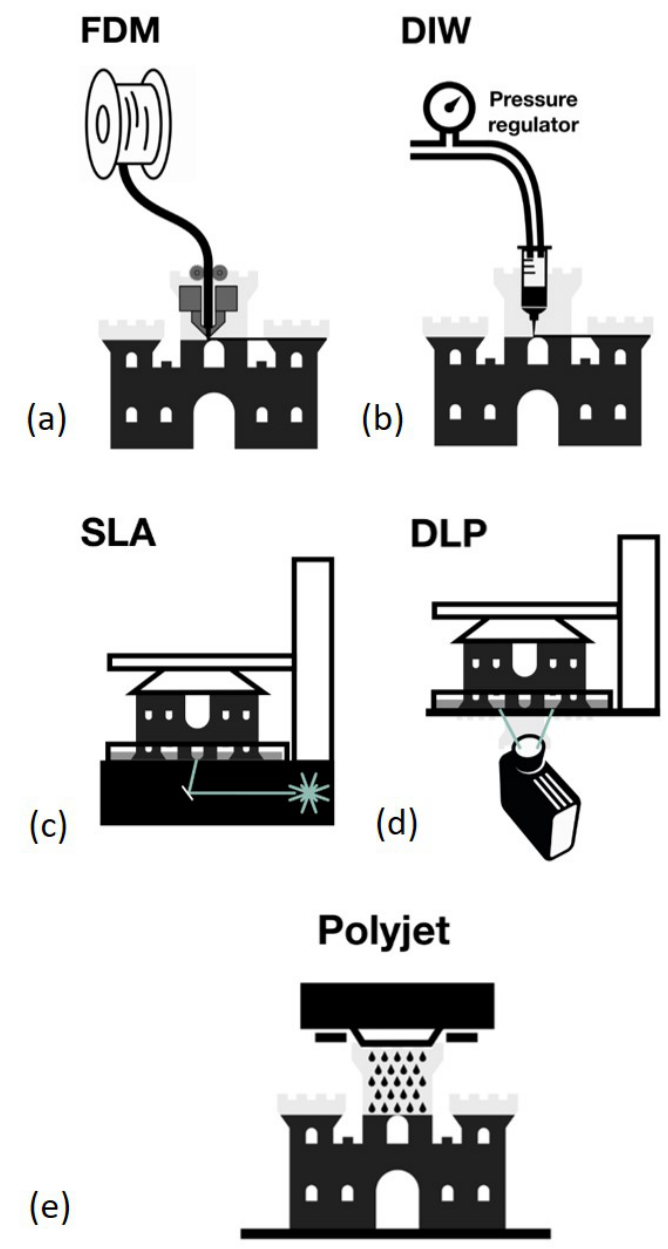
Figure 5. Current 3DP techniques applied in droplet microfluidics. ( a ) Fused deposition modeling (FDM). ( b ) Direct ink writing (DIW). ( c ) Stereolithography (SLA). ( d ) Digital light processing (DLP). ( e ) Photopolymer inkjet printing